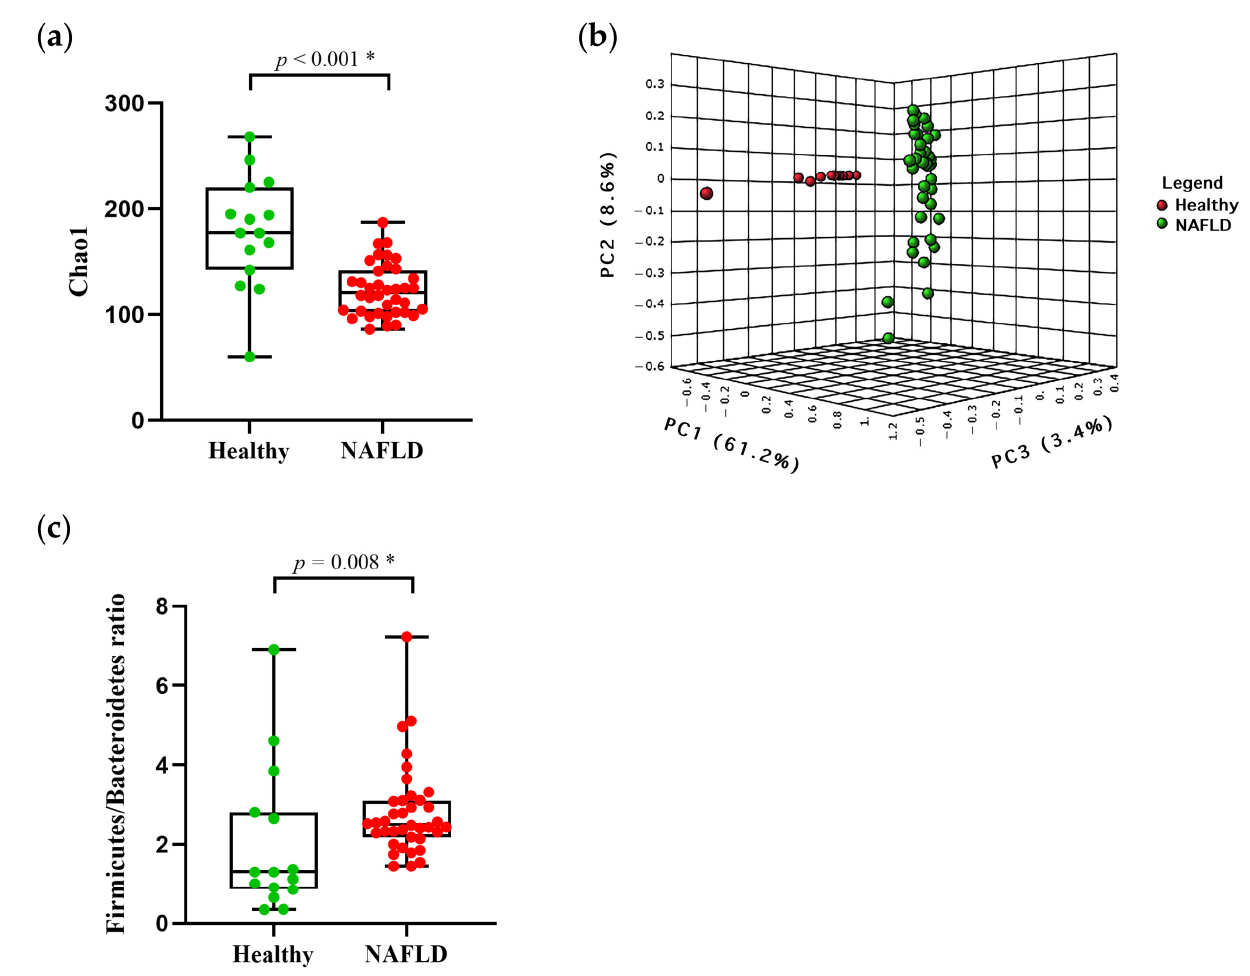
Figure 2. Gut bacterial diversities and Firmicute/Bacteroidetes ratio in healthy controls and patients with NAFLD at week 0 ( a ) Alpha diversity (Chao1); ( b ) Beta-diversity (Bray–Curtis distance); ( c ) Firmicute/Bacteroidetes ratio. * p < 0.05; NAFLD, Non-Alcoholic Fatty Liver Disease; PC, Prin- cipal